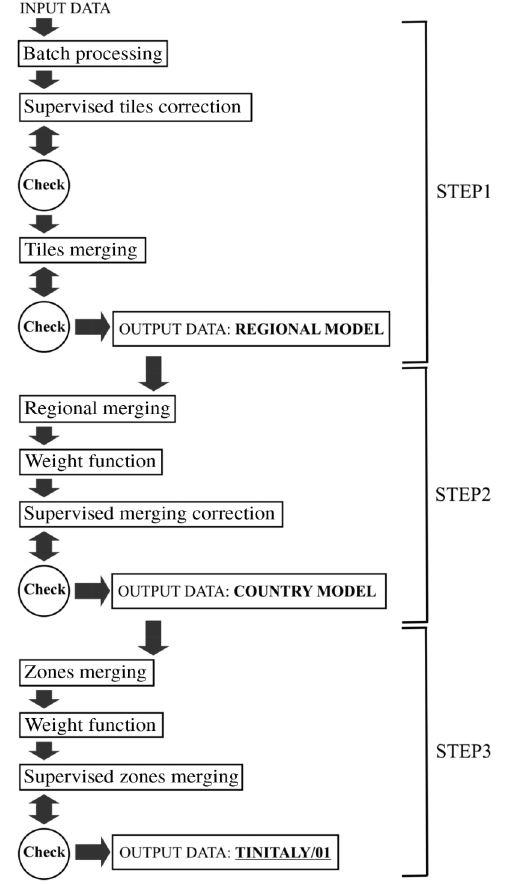
Fig. 4. Flow chart of data processing procedure for the creation of the TINITALY/01. Data check im- plies the creation of shaded relief images where arti- facts appear as erratic scars, anomalous ditches, sharp peaks or deep ridges.